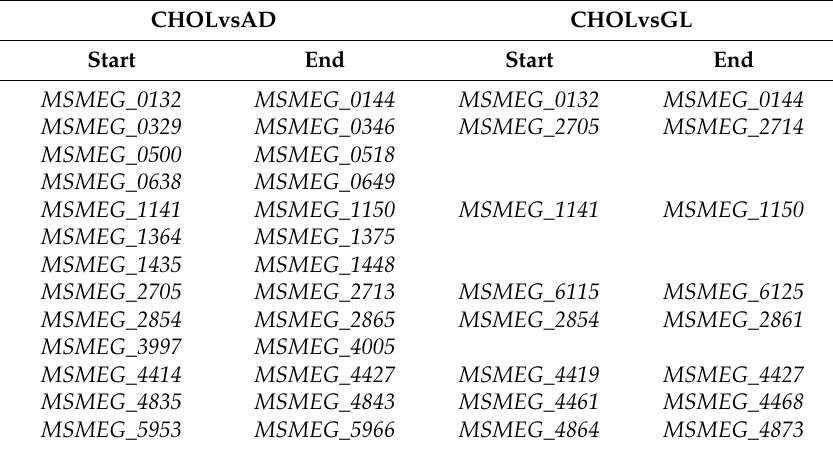
Table 3. Gene clusters induced by cholesterol. AD, CHOL and GL correspond to three different conditions: 20 mL minimal medium plus with 1.75 mM androstenedione, 1.29 mM cholesterol and 5.47 mM glycerol respectively. CHOLvsAD